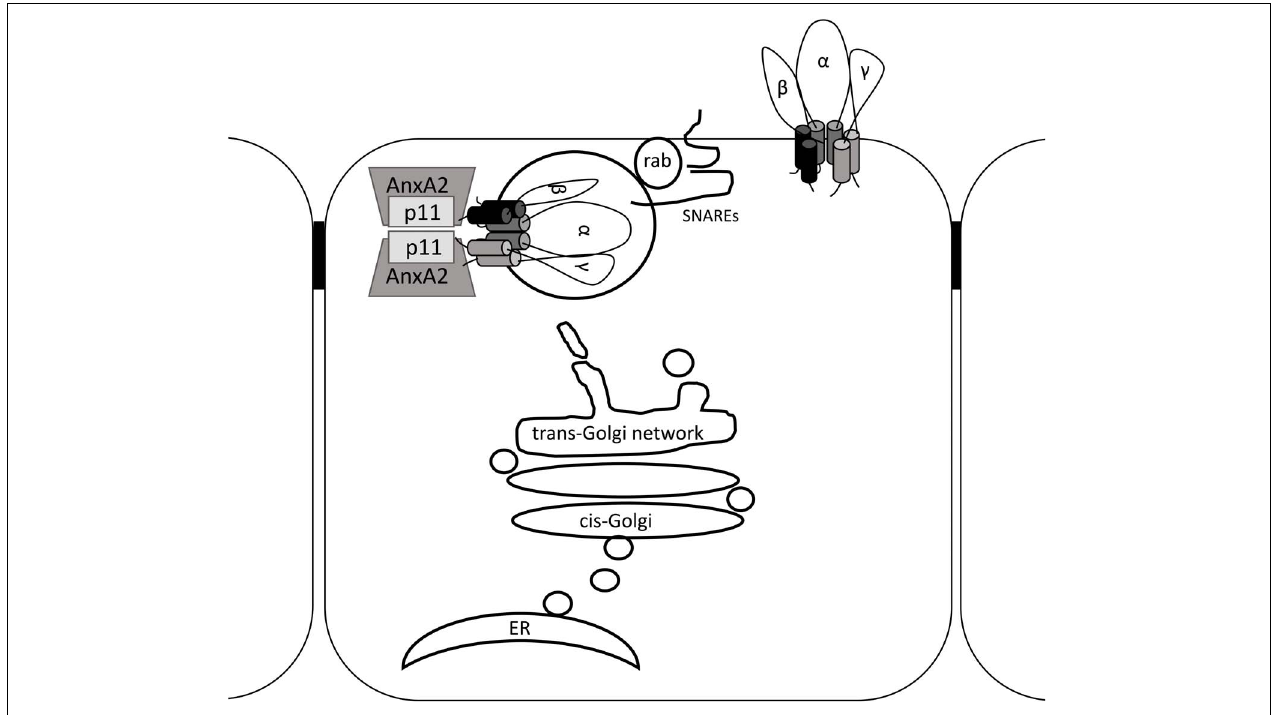
FIGURE 8 | Schematic for p11 in ENaC trafficking. ENaC is translated at the endoplasmic reticulum (ER) and is modified by glycosylation, folded and assembled in the ER. ENaC is then moved to the cis -Golgi and emerges from the trans -Golgi network (TGN) in vesicles or tubules. The Annexin II-p11 tetramer may associate directly with vesicular ENaC and assist with apical targeting and tethering. At the apical membrane rab, v-SNARE, and t-SNARE molecules in the vesicle and apical membrane respectively will promote vesicle fusion, delivering ENaC to the apical cell surface. Not to